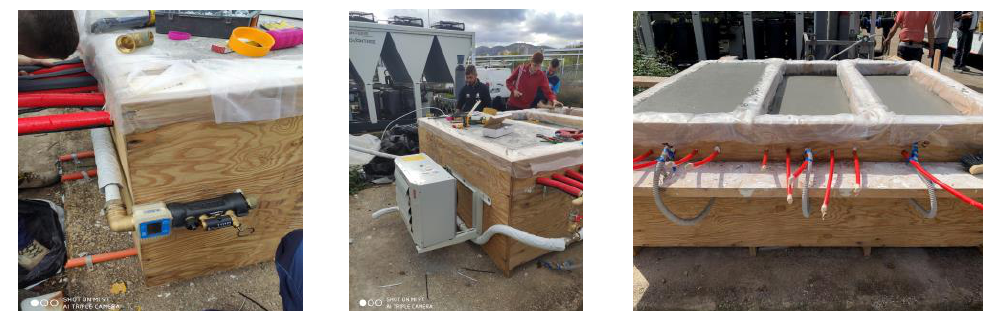
Figure 4. Some phases of the installation of the RTC Box.